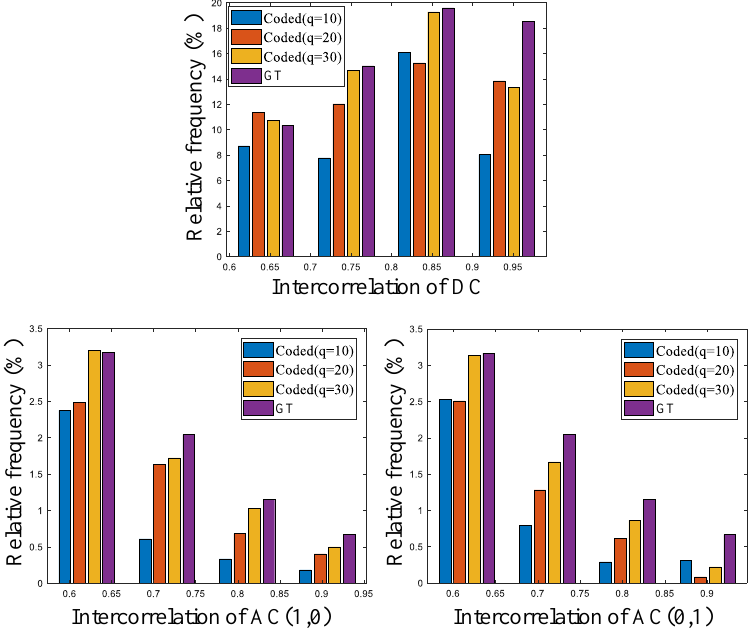
Figure 5. Intercorrelation distribution according to compression level.